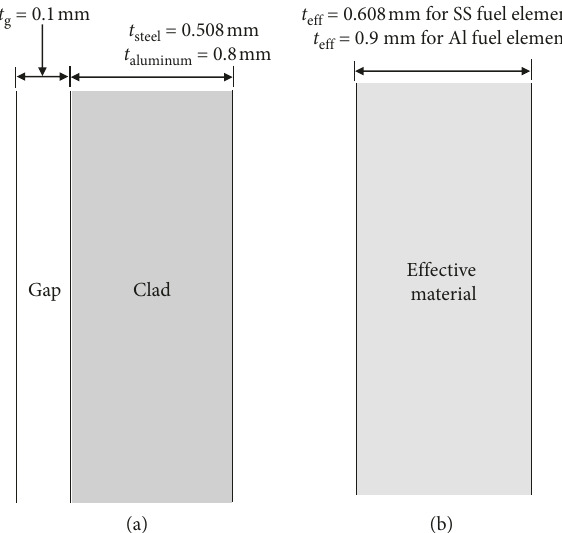
Figure 10: The thickness of (a) gap and clad in the fuel element and (b) effective material in the COMSOL